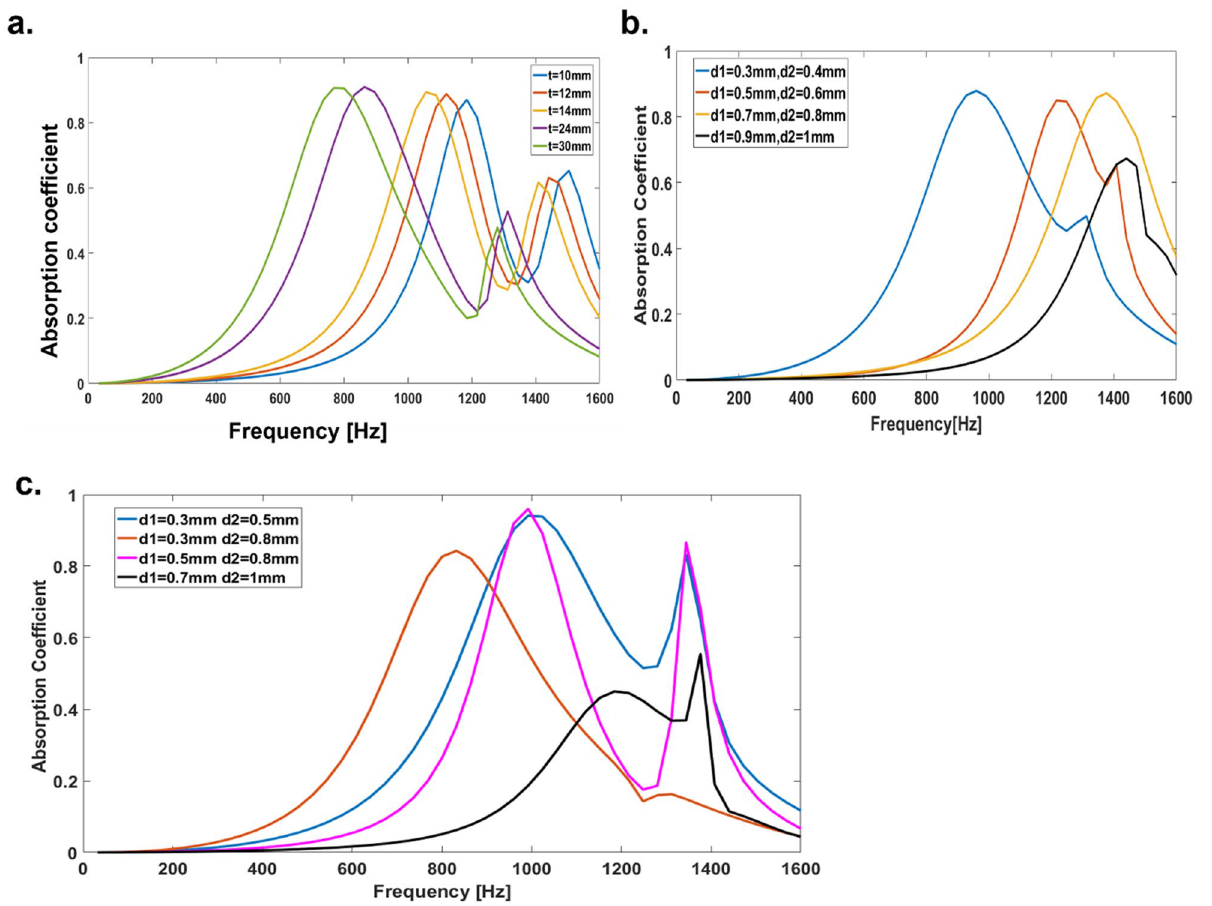
Figure 3. Sound absorption coefficient of CMPP with different acoustic parameters. ( a ) Thickness of the fractals core. ( b,c ) Porosity of CMPP. Courtesy (MATLAB R2016a) 46 .